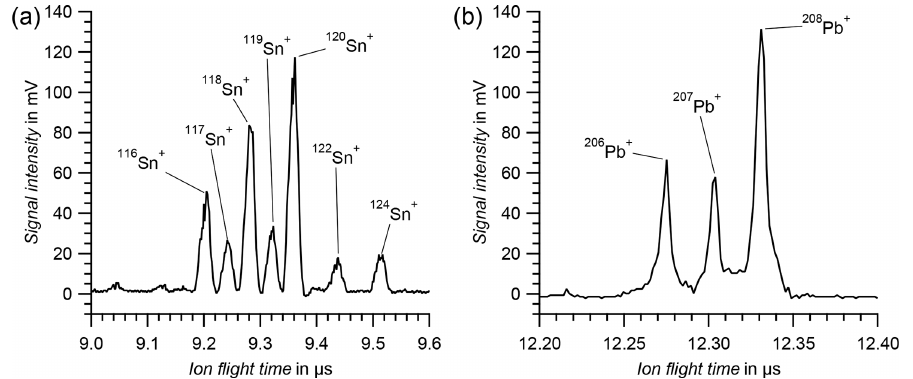
Figure 10. Details of cation raw spectra (voltage output versus ion flight time in the B-ToF-MS) of two ambient single particles at the airport of Kathmandu, Nepal. (a) Tin isotopic pattern ( d va = 277nm). (b) Lead isotopic pattern ( d va = 311nm).